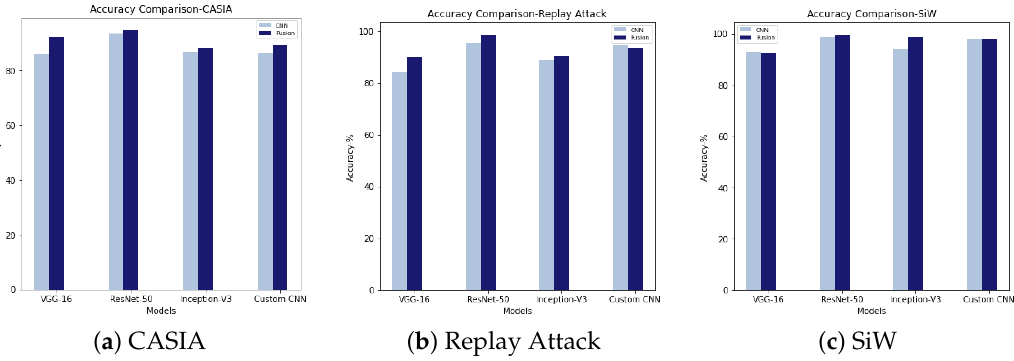
Figure 7. Accuracy comparison for CASIA, Replay Attack, and